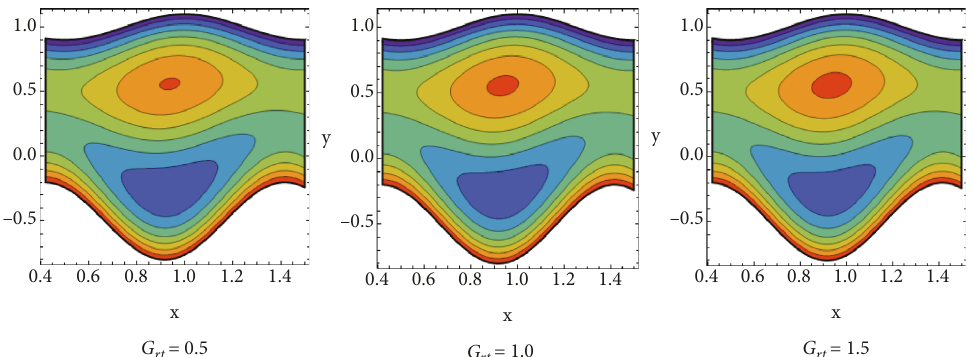
Figure 11: Impact of streamlines on G